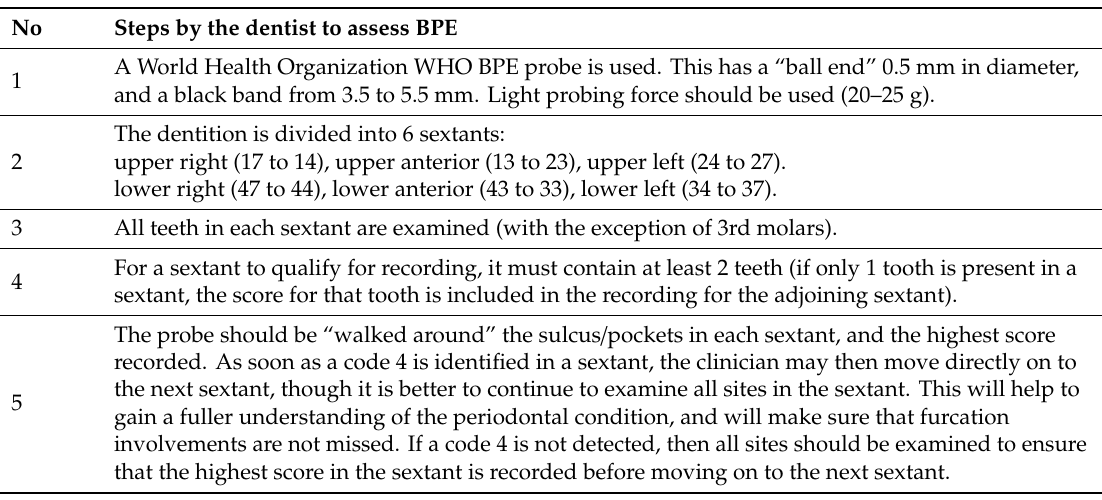
Table 4. Method of determining Basic Periodontal Examination (BPE) indicators.